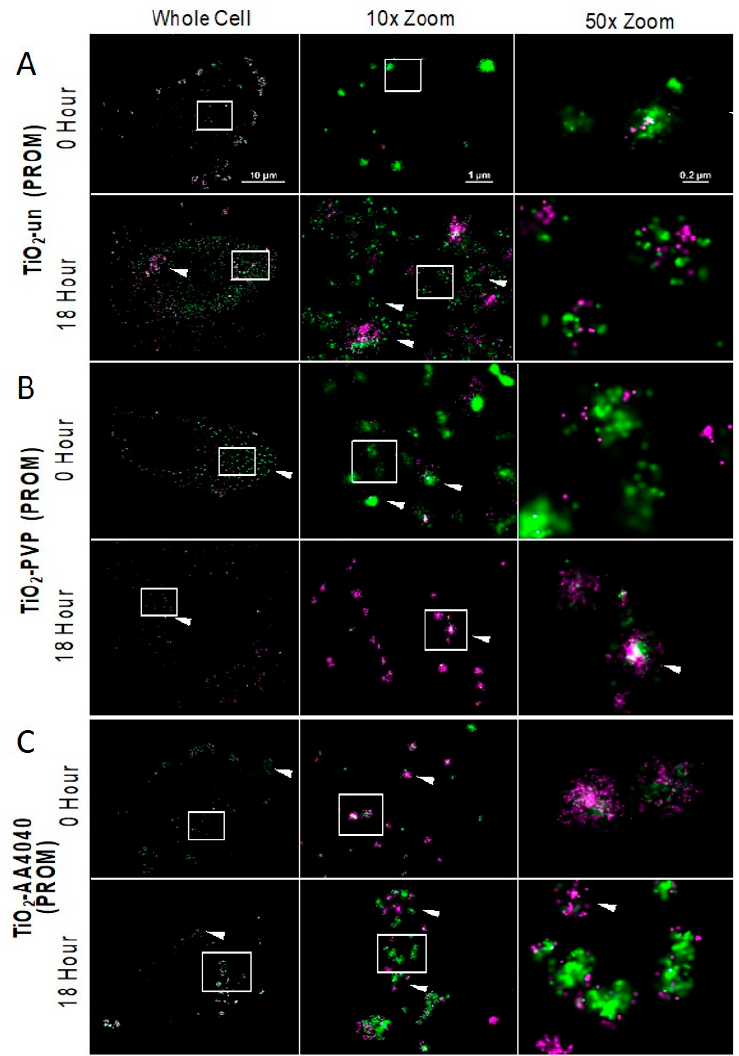
Figure 7. STORM acquisitions of A549 cells treated with TiO 2 NMs. ( A ) Uncoated TiO 2 at 0 and 18 h, ( B ) TiO 2 -PVP at 0 and 18 h and ( C ) TiO 2 -dispex at 0 and 18 h. At 0 h, uncoated (TiO 2 -un), PVP-coated (TiO 2 -PVP), and Dispex-AA4040 (TiO 2 -AA4040)-coated NMs demonstrate different behaviors. TiO 2 -PVP NMs are internalized as discrete, spherical spots which strongly associate with FITC-labeled protein (initial corona). In comparison, uncoated and dispex-AA4040-coated NMs form large agglomerates which associate with both FITC protein and Alexa-647 protein, forming an initial (green) and exchanged (magenta) corona. At 18 h post incubation, TiO 2 -PVP NMs have adsorbed a secondary layer of protein and formed larger agglomerates. Conversely, TiO 2 -un NMs appear to have lost the FITC-serum signal, and are instead associated with Alexa-647-labeled proteins. Interestingly TiO 2 -AA4040 NMs are internalized as large agglomerates which retain their initial corona (FITC) signal at the later time point observed. Reconstructions were performed using the NIS Element STORM module, with a density filter restricting molecules to clusters of 15 molecules within 200